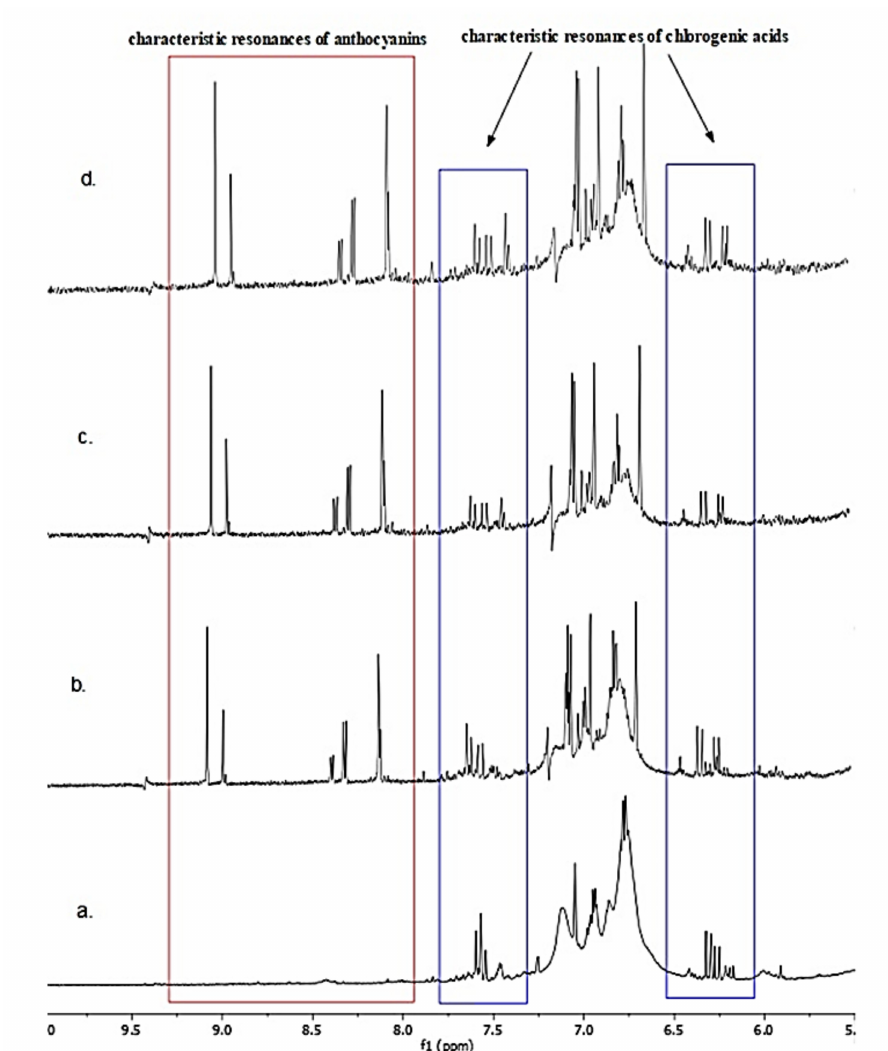
Figure 1. 1 H-NMR spectra of fruit samples from farm 1-LS (aromatic area from 5.5 to 10.0 ppm with diagnostic signals for anthocyanins (red frame) and chlorogenic acid (blue frame)): ( a ) LS1, ( b ) LS6, ( c ) LS9, ( d )